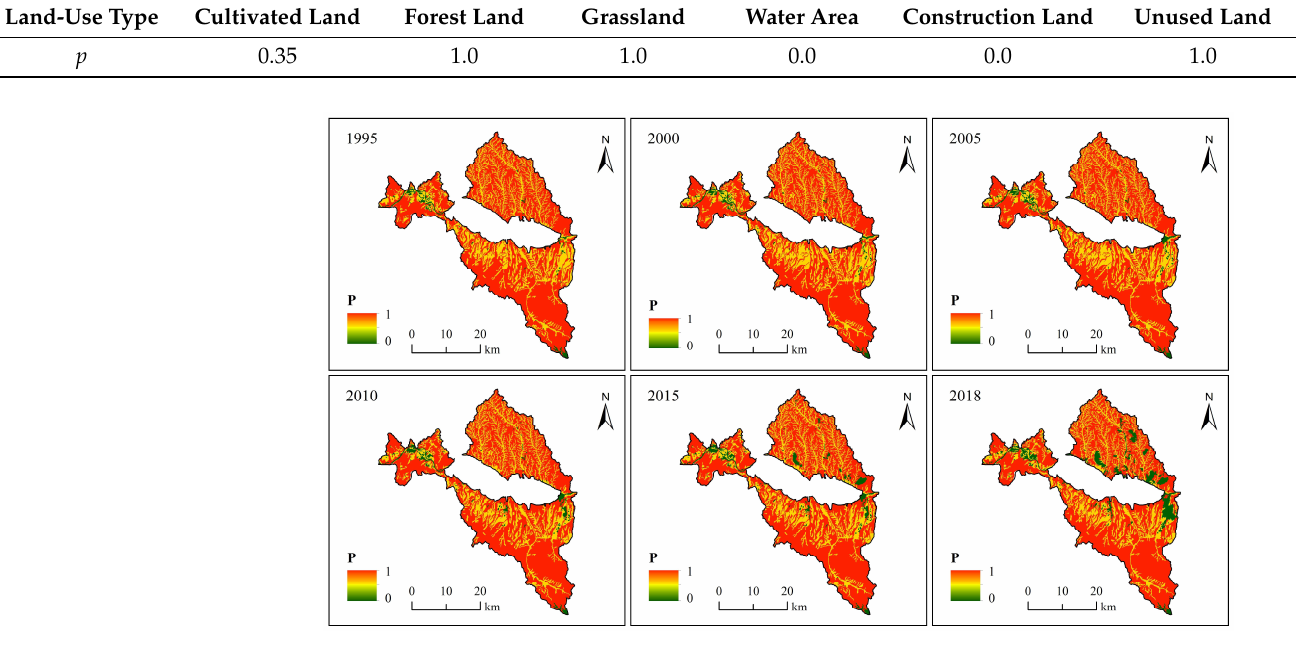
Figure 6. Spatial distribution of soil and water conservation measures factors in the South and